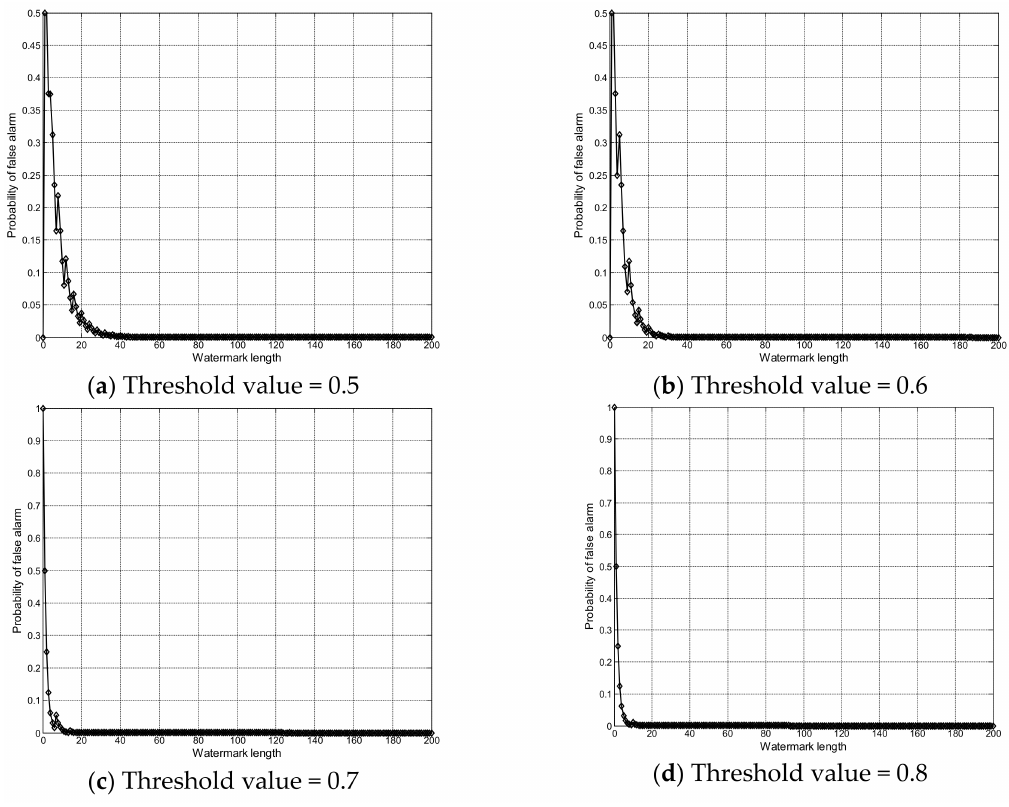
Figure 13. Probability of false alarm versus watermark